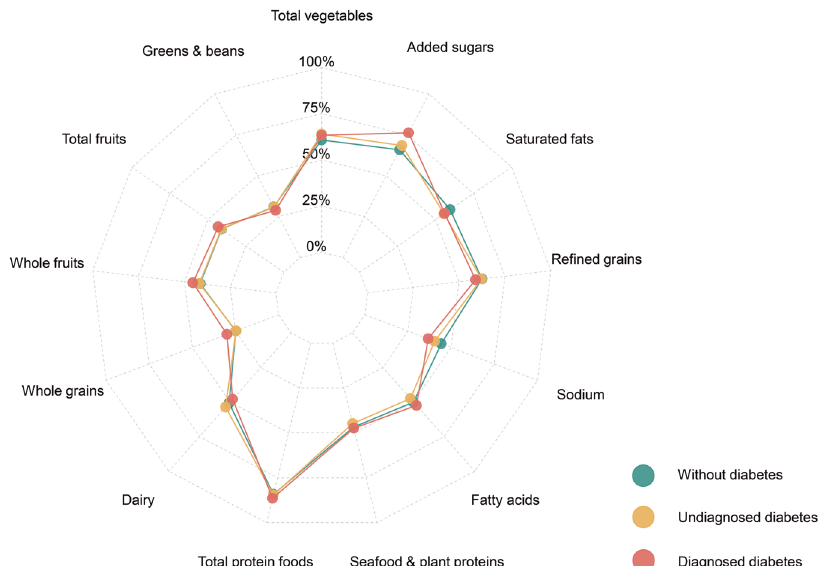
Fig. 2 Characteristics of healthy eating index components by baseline diabetes diagnoses. Each component score was divided by the maximum score of that